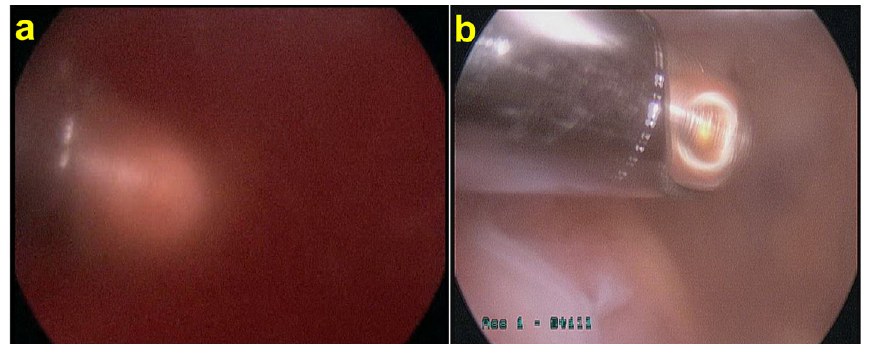
Figure 5. (a) Stormy appearance when the scope is inserted in the suprapatellar pouch, (b) debridement of the suprapatellar pouch using shaver with suction.